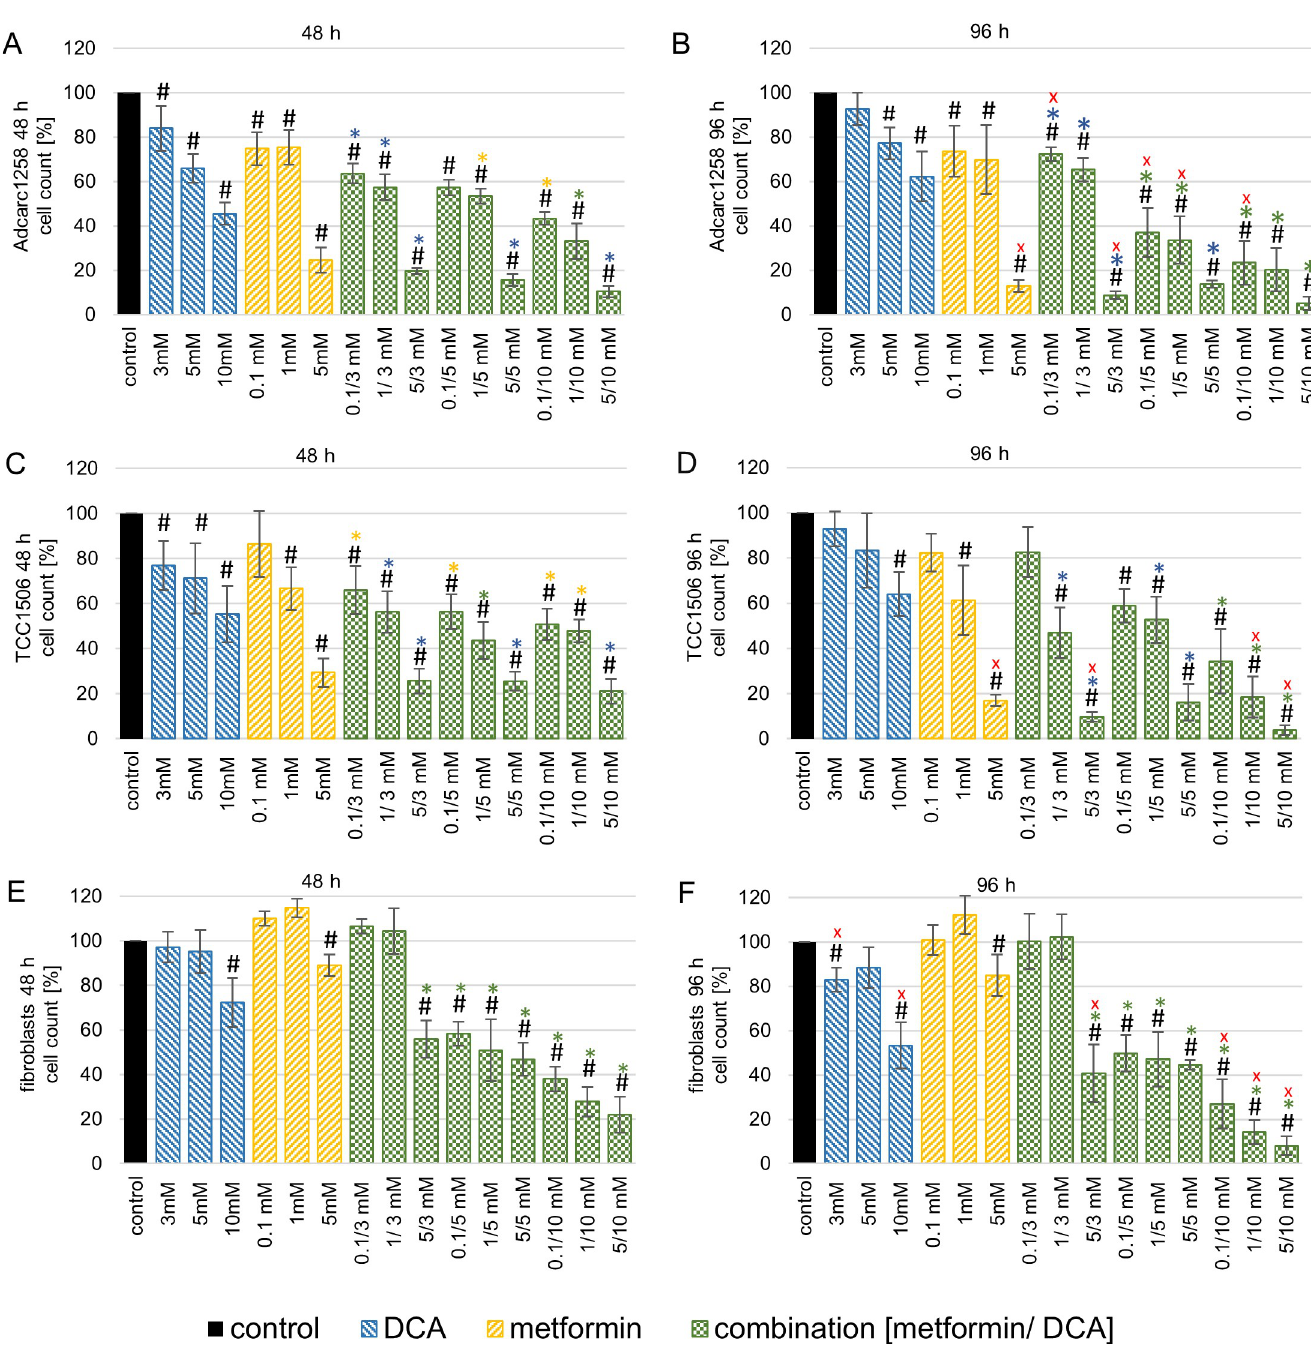
PLOS ONE | https://doi.org/10.1371/journal.pone.0257403 September 27,